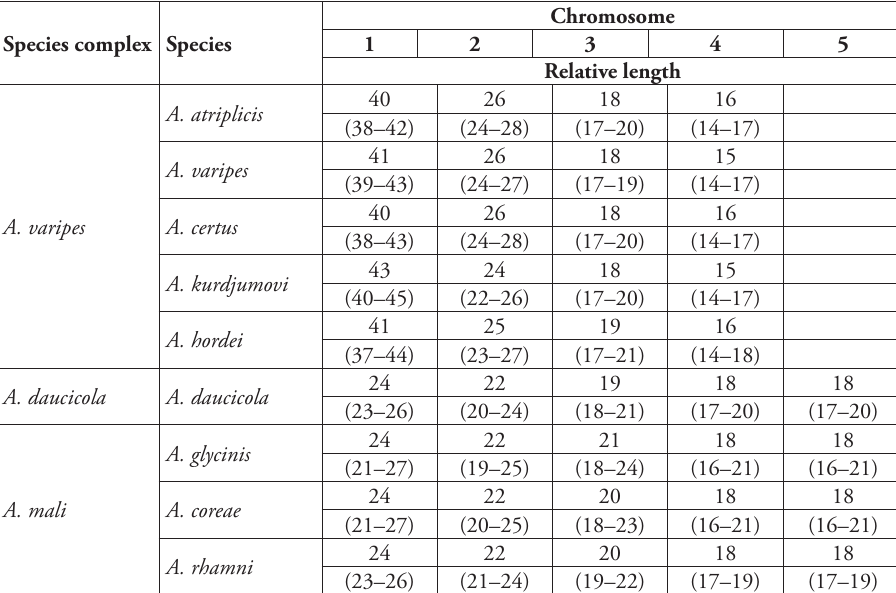
Table 4. Relative lengths of chromosomes in Aphelinus species . Means with 95% confidence intervals in